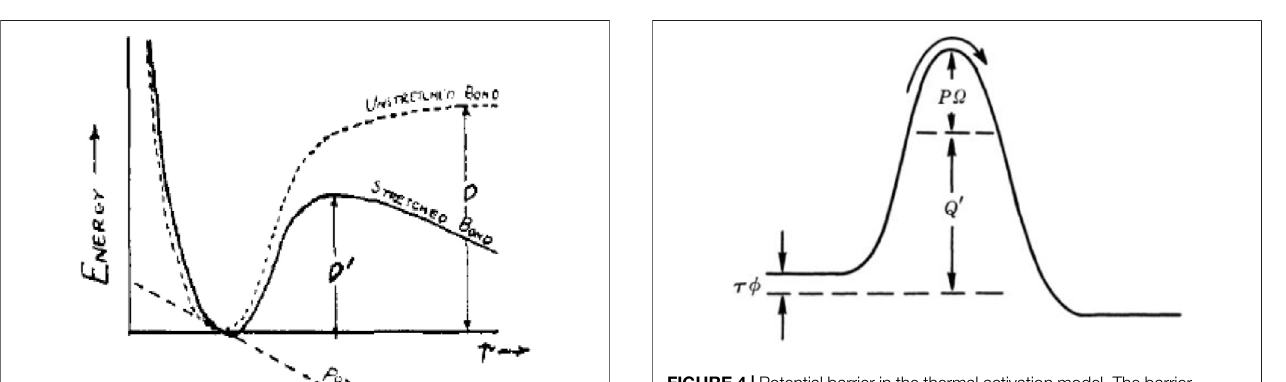
FIGURE 4 | Potential barrier in the thermal activation model. The barrier is modi fi ed by the in fl uence of pressure P and shear stress τ (Briscoe and Evans,